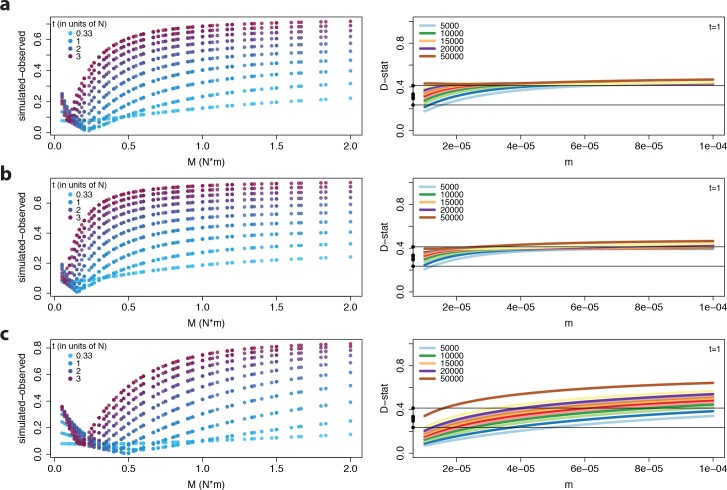
Model output for all three gene flow scenarios.